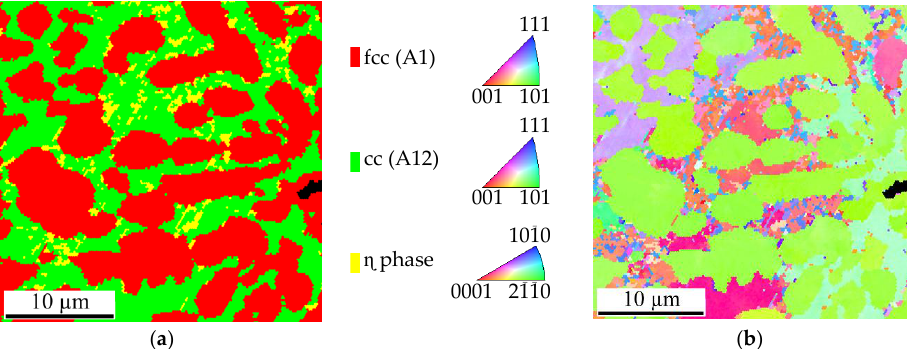
Figure 5. Al 0.2 CoCrFeNiTi ( a ) phase map and ( b ) orientation distribution, color-coded according to the unit triangle of the inverse pole figure (IPF).